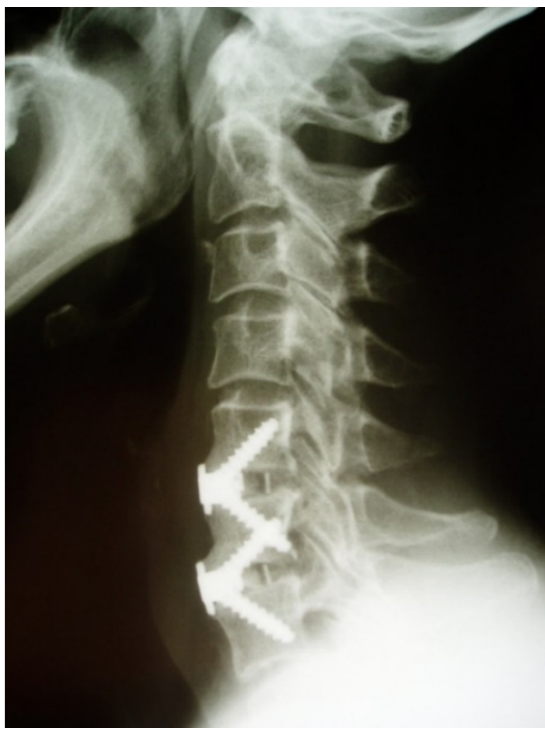
Fig. 2. The method of evaluation of CobbS and CobbG (authors’ archive).